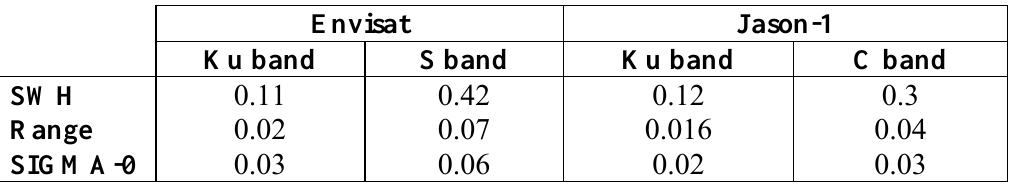
Table 1. Standard deviation (m for SWH and Range, dB for Sigma0) of the 1-Hz measurements for Envisat and Jason-1 for the Ku and C or S bands for standard conditions (2-m SWH and 11-dB backscatter coefficient or